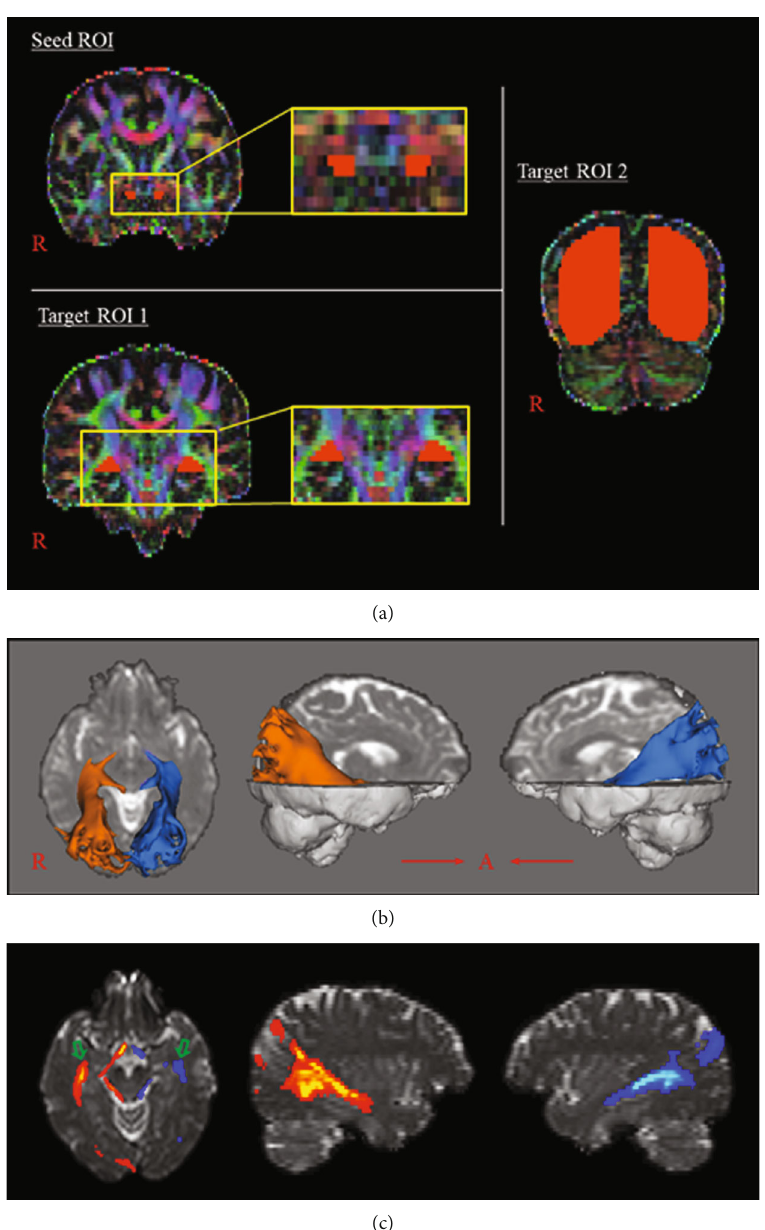
Figure 2: Reconstruction of the optic radiation (OR) using a probabilistic algorithm (the Oxford Centre for Functional Magnetic Resonance Imaging of Brain Software Library; http://www.fmrib.ox.ac.uk/fsl). (a) Regions of interest (ROIs): seed ROI, the optic tract posterior to the optic chiasm in the coronal plane; target ROI 1, the lateral geniculate body in the coronal plane; target ROI 2, the bundle of the OR at the posterior one-third portion between the lateral geniculate body and the primary visual cortex. (b) Results of di ff usion tensor tractography of the OR. (c) Axial and sagittal slices of probabilistic tractography show reconstruction of the OR with Meyer ’ s loop (green